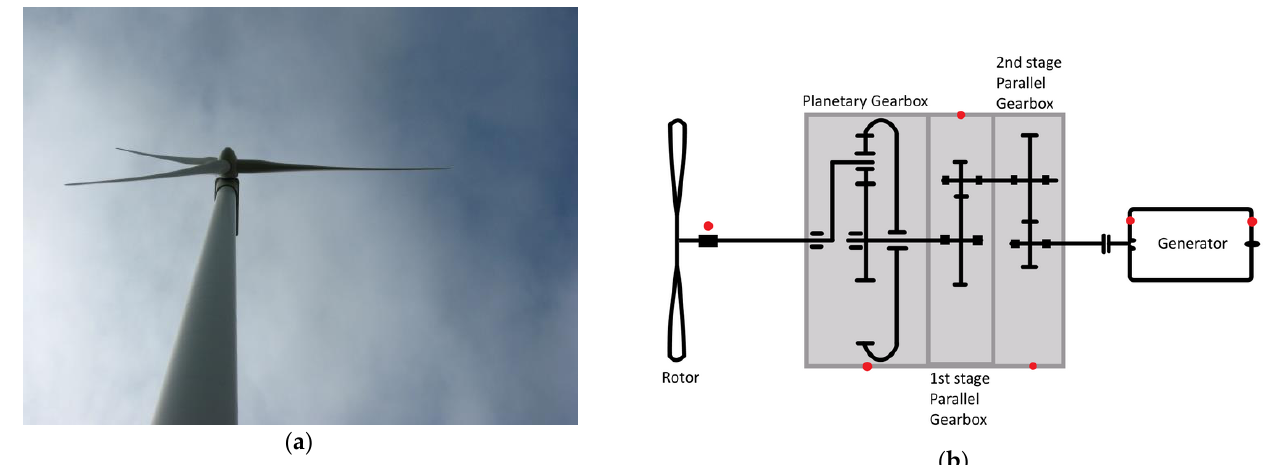
Figure 4. The wind turbine used in this study: ( a ) general view; ( b ) kinematic scheme with locations of vibration sensors (red dots).